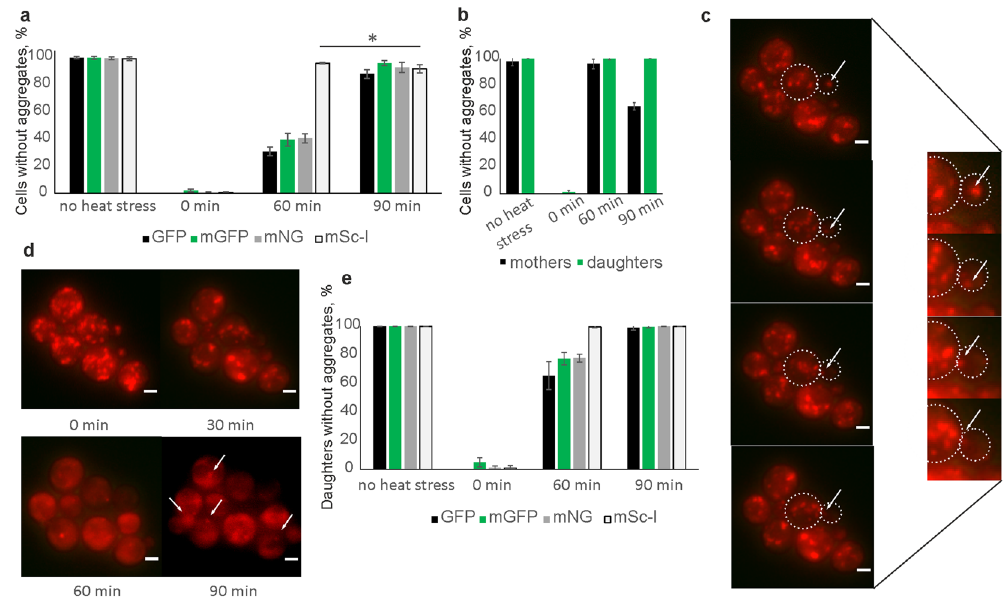
Figure 3. Heat-induced damaged protein aggregates removal efficiency. ( a ) Mean percent of cells without aggregates before the stress, immediately after, 60 and 90 min after cells were returned into their standard growth conditions (recovery). Cells expressing Hsp104 fused with GFP (black), mGFP (green), mNeonGreen (grey) and mScarlet-I (white) were tested. Error bars represent standard deviation. *p < 0.05, Student’s t-test. ( b ) Mean percent of mother (black) and daughter (green) cells expressing Hsp104-mScarlet-I before stress, immediately after, 60 and 90 min recovery. Standard deviation error bars. ( c ) Representative images of cells with Hsp104-mSc-I recovering after the heat stress (15–30 min). White arrows indicate a fluorescent focus being dragged from the daughter (smaller cell) to the mother (larger) cell. Cellular boundaries are indicated. Scale bar 2 µm. Inset: contrast-enhanced magnification of the bud neck between the mother and daughter cell. ( d ) Representative image of Hsp104-mSc-I cells recovering from the heat stress (0–90 min). White arrows indicate fluorescent foci reappearing in the mother cells after 90 min recovery. Scale bar 2 µm. ( e ) Mean percent of daughter cells without aggregates before and after heat stress. Cells expressing Hsp104 fused with GFP (black), mGFP (green), mNeonGreen (grey) and mScarlet-I (white) were tested. Standard deviation error